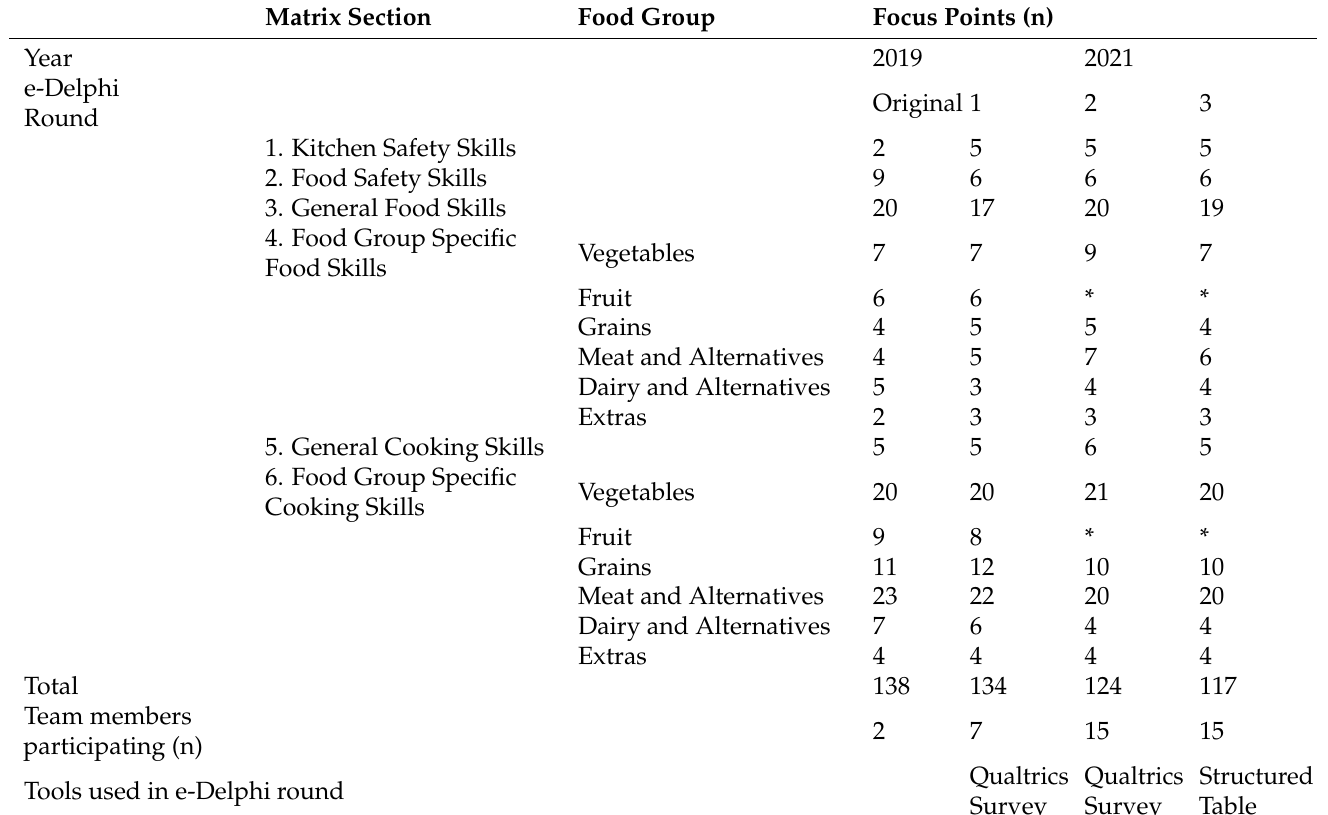
* Fruit merged with Vegetables subgroup from round